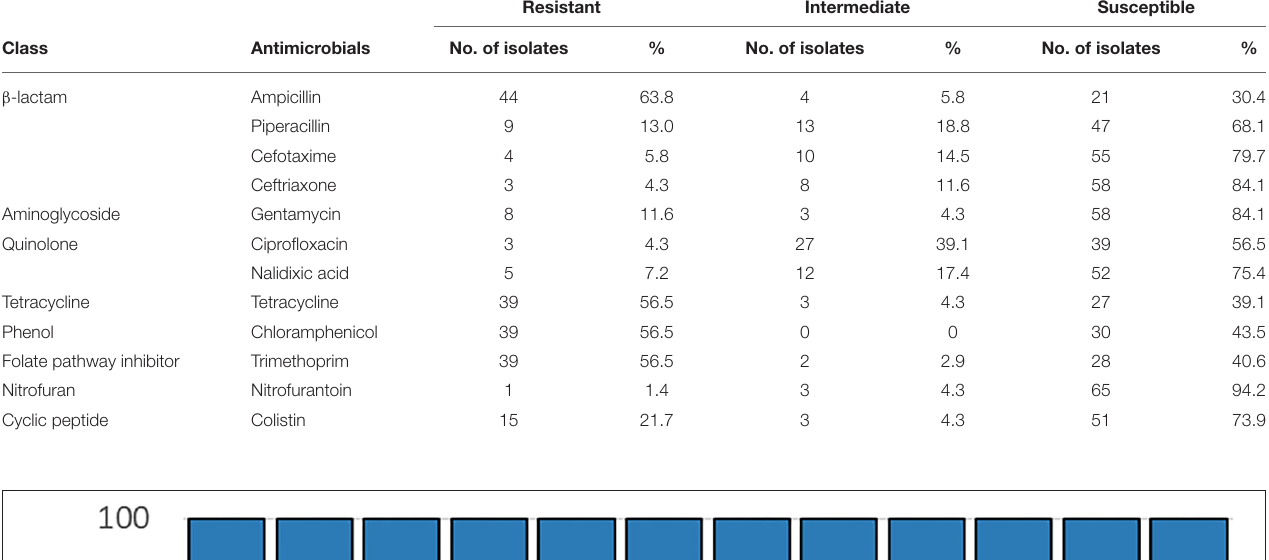
TABLE 2 | Summary of antimicrobial susceptibility testing for 69 isolates. Phenotypic resistance classified using EUCAST and CLSI guidelines. Resistant Intermediate Susceptible